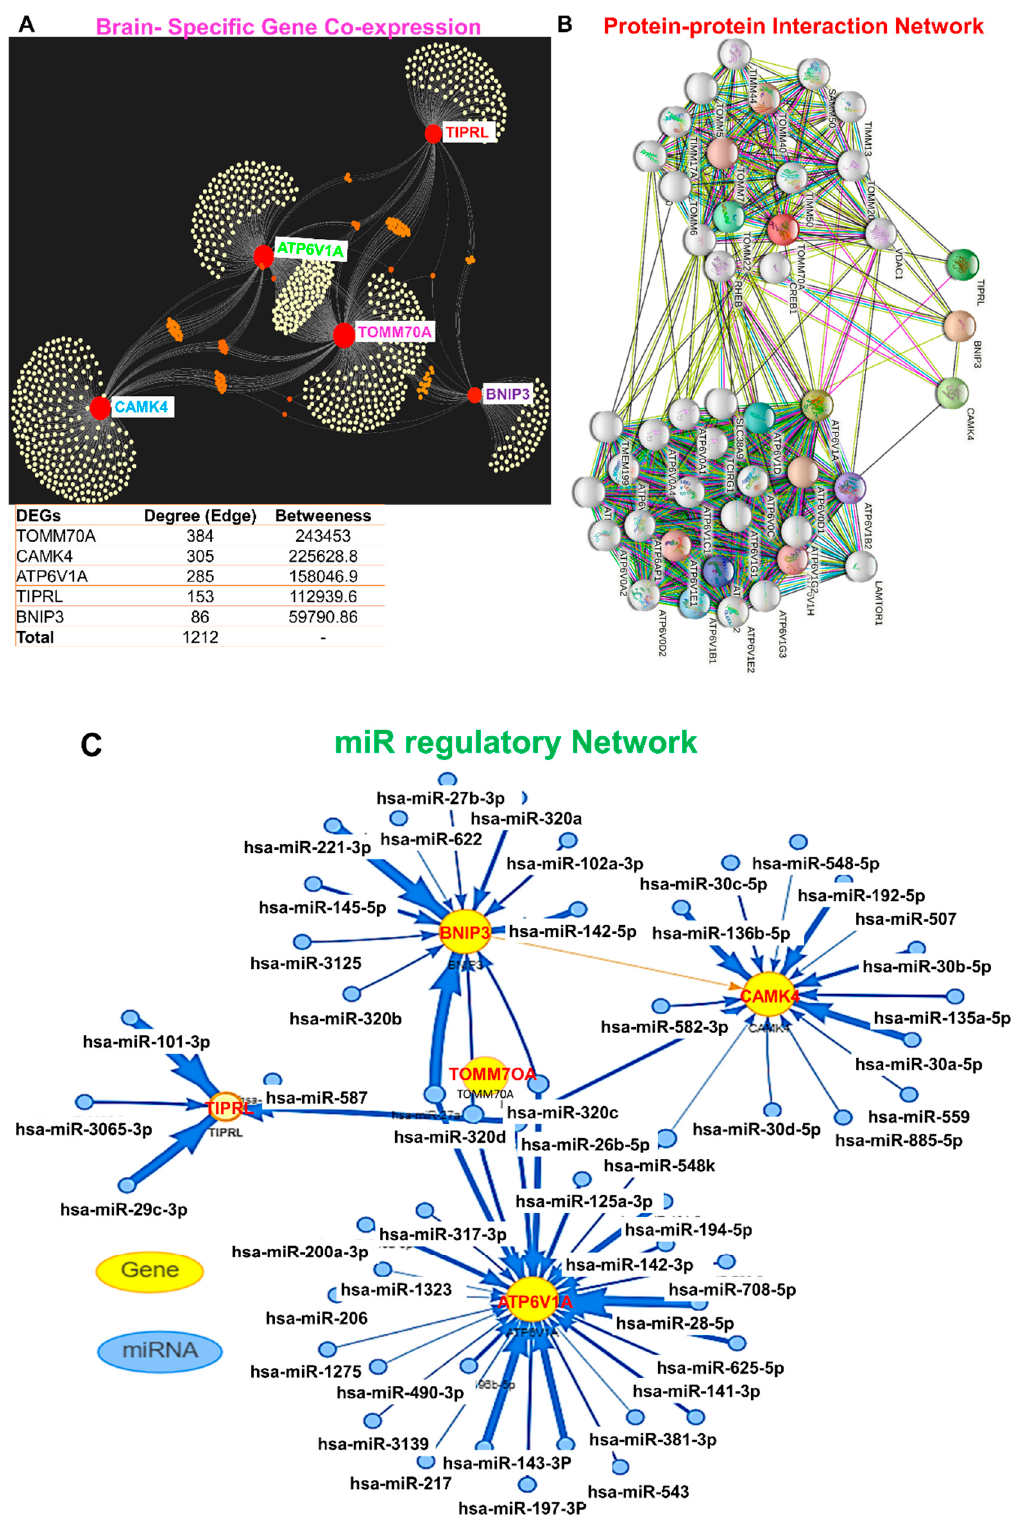
Figure 4. MicroRNA (miR) regulatory network and brain-specific gene interactions of ATP6V1A , BNIP3 , CAMK4 , TIPRL , and TOMM70 ( A ) Network plot of brain-specific gene co-expressions of the gene set, ( B ) protein–protein interaction (PPI) network, and ( C ) miR regulatory networks of target genes.